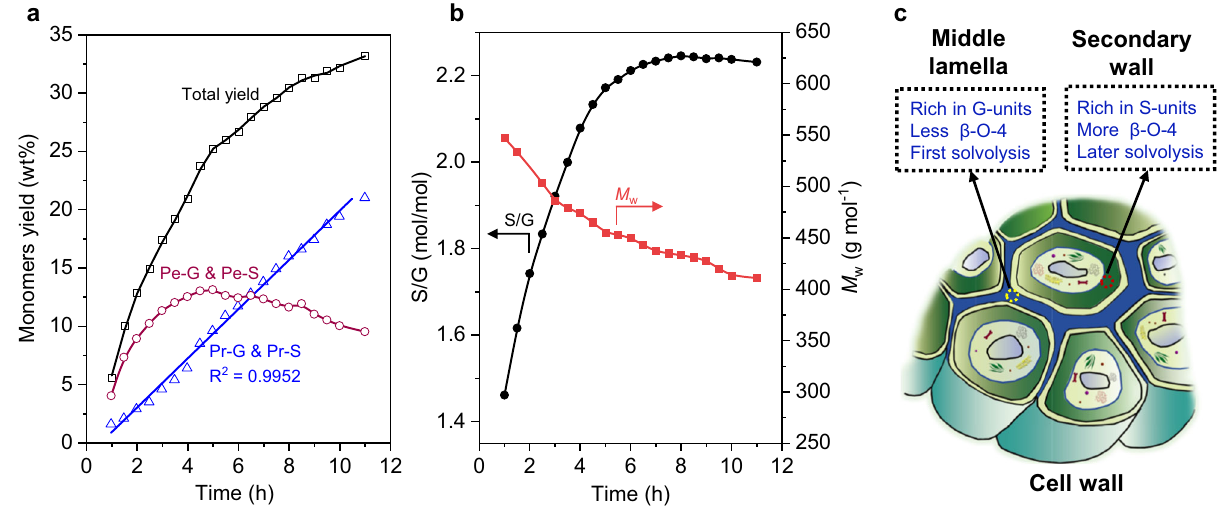
Fig. 5 | Time pro fi le of the birch RCF reaction over the RuN/ZnO/C catalyst. a Cumulative monomer yields. b S/G ratios of monomers and average molecular weightsof ligninoils. c Illustrationof thecellwall.The reactionwasperformedina